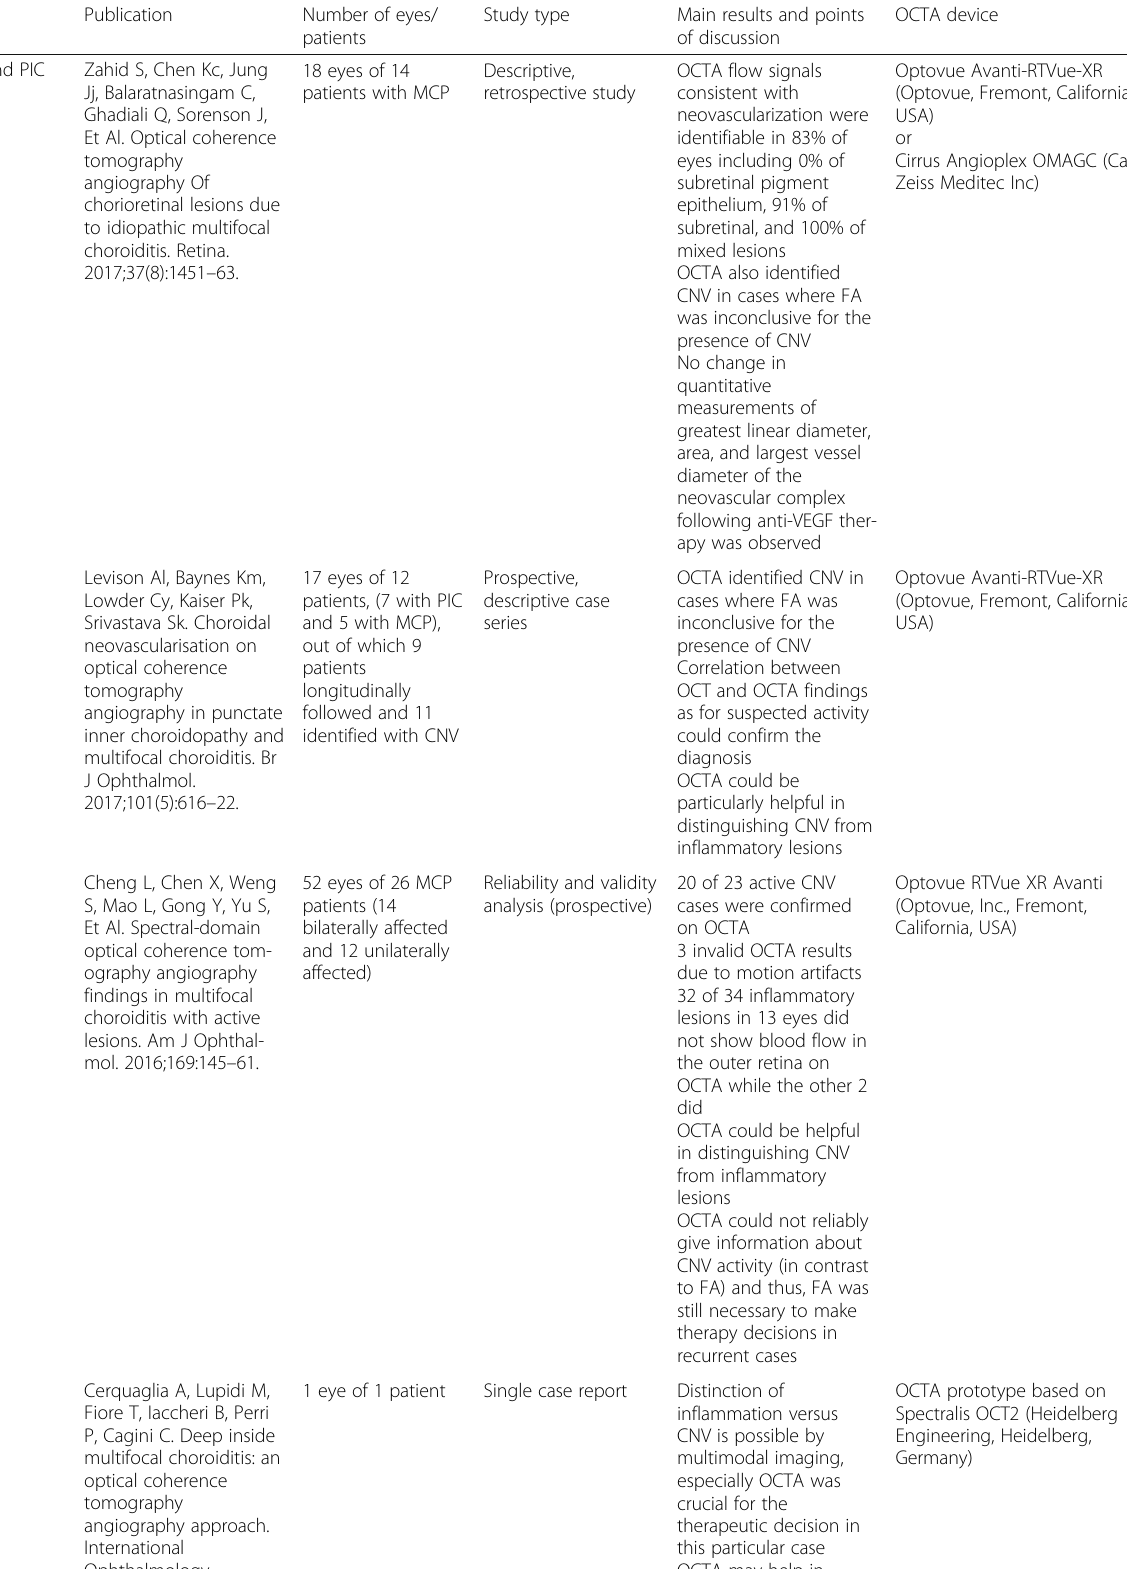
Table 1 Summary of publications on the implementation of OCTA in white dot syndromes